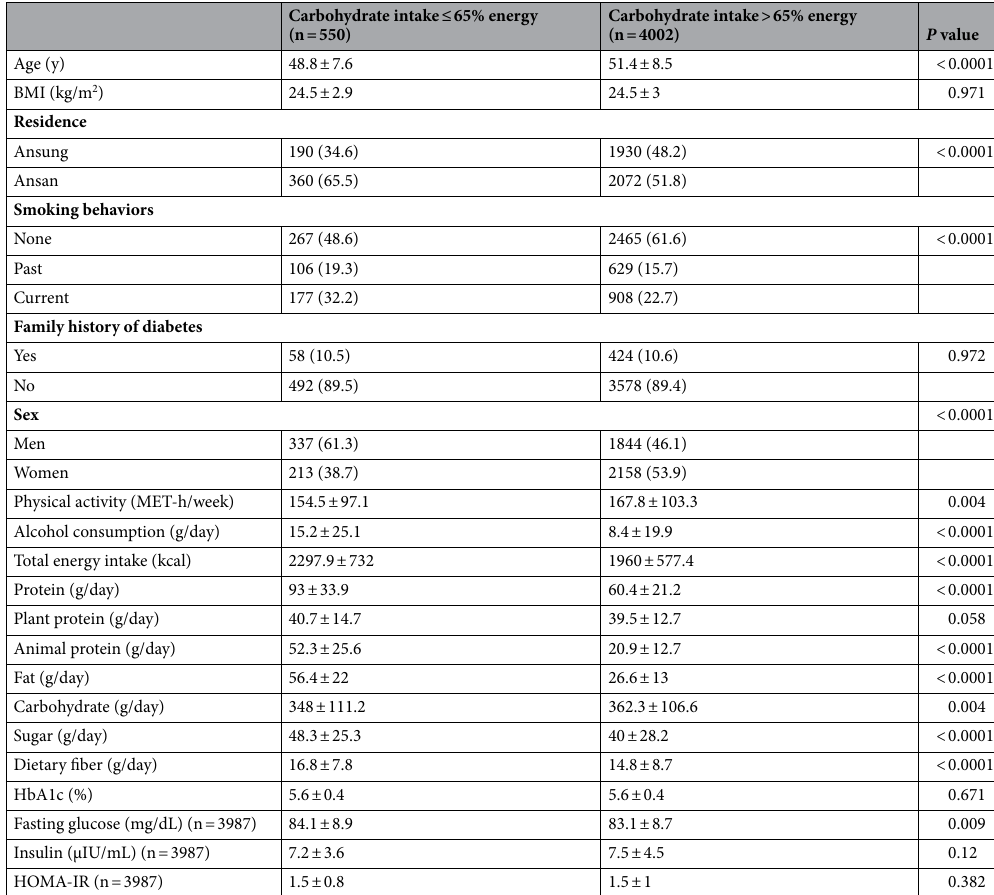
Table 2. General subject characteristics, stratified by carbohydrate intake. Data are presented as mean ± standard deviation or n (%). P values are from chi-square tests for categorical variables and t-tests